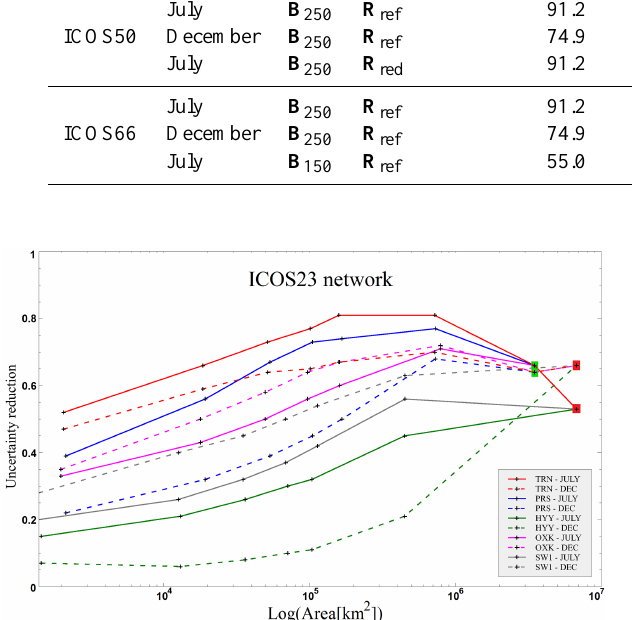
Figure 5. Uncertainty reduction (theoretically comprised between 0 and 1) for a 2-week-mean NEE in July and December 2007 us- ing ICOS23 and the reference configuration of the inversion, as a function of the size (logarithmic scale) of the spatial averaging area (in km 2 ; as indicated by the crosses, for each curve values are derived for 1.5 ◦ × 1.5 ◦ , 2.5 ◦ × 2.5 ◦ , 3.5 ◦ × 3.5 ◦ , 4.5 ◦ × 4.5 ◦ and 10.5 ◦ × 10.5 ◦ areas, which correspond to different values in terms of km 2 depending on their location in Europe) around each station: TRN (red curves), PRS (blue curves), HYY (green curves), OXK (pink curves) and SW1 (grey curves; see the locations in Fig. 1c). Solid and dash lines correspond to results for July and December, respectively (see the legend within the figure). The results of uncer- tainty reduction for the whole European domain are included (red rectangles). The results for the western European domain defined in Fig. 1c are included on curves corresponding to sites that are located in this domain (TRN, PRS and OXK; see the green rectangles).